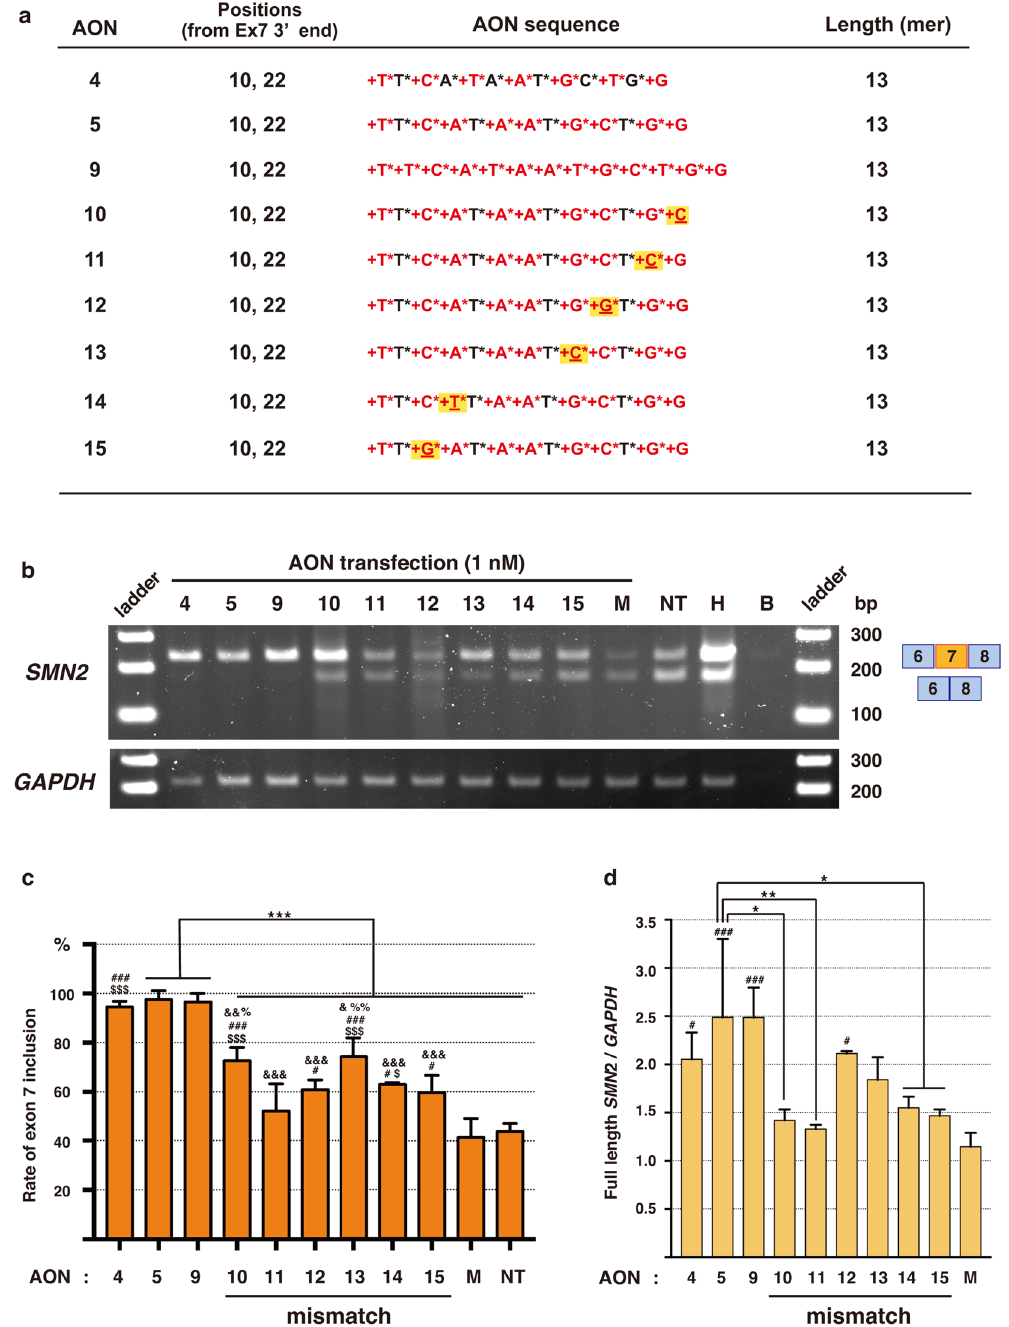
Figure 5. A single mismatch in the LNA/DNA mixmers abrogates the activity of them for exon 7 inclusion. ( a ) LNA/DNA mixmer sequences used for the experiment. The LNA/DNA mixmers #10–15 contain a single base mismatch at various locations along the sequence. AON #9 consists of 100% LNA. DNA base: G, A, T, C. LNA base (red): + G, + A, + T, + C. Phosphorothioated DNA base: G * , A * , T * , C * . Phosphorothioated LNA base (red): + G * , + A * , + T * , + C * . Yellow highlighted: mismatch. ( b ) RT-PCR of SMN2 and GAPDH in human SMA patient fibroblasts (GM03813). AONs were transfected at 1 nM concentration. Top band: exon 7-included. Bottom band: exon 7-excluded. ( c ) Quantification of SMN2 exon 7 inclusion in AON-treated SMA fibroblasts by RT-PCR. *** p < 0.005. # Significant difference with the mock ( # p < 0.05, ## p < 0.01, ### p < 0.005). $ Significant difference with the non-treated ( $ p < 0.05, $$ p < 0.01, $$$ p < 0.005). & Significant difference with AON 4 ( & p < 0.05, && p < 0.01, &&& p < 0.005). % Significant difference with AON 11 ( % p < 0.05, %% p < 0.01). ( d ) Relative expression of full-length SMN2 to GAPDH measured by qPCR. The data were normalized to non-treated cells. * p < 0.05, ** p < 0.01, *** p < 0.005. # Significant difference with the mock ( # p < 0.05, ## p < 0.01, ### p < 0.005). Bars represent mean ± S.D. of three independent experiments. One-way ANOVA with a Tukey’s multiple comparison test. M: mock control AON, NT: non-treated, H: healthy cells, B: